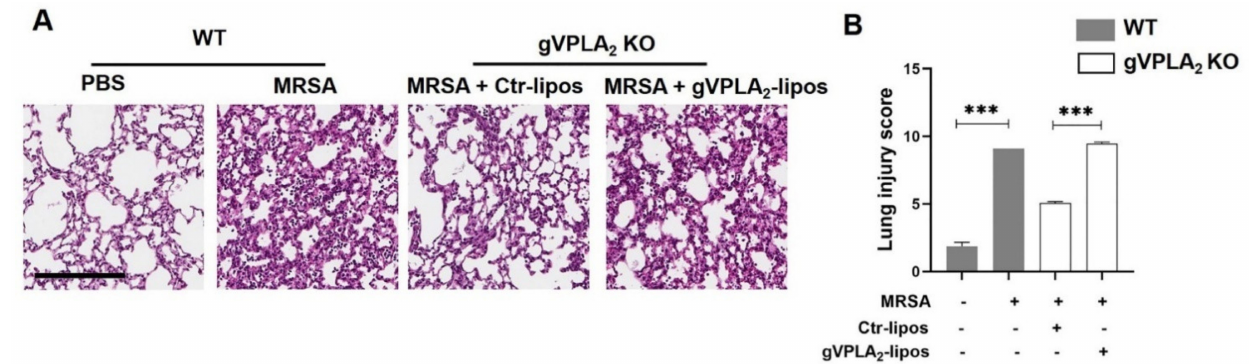
Figure 9. Effects of gVPLA 2 expression on lung tissue histopathology. H&E staining of lung sections that were obtained from WT or gVPLA 2 KO mice treated with live MRSA-USA300 (0.75 × 10 8 CFU/mouse) intratracheally for 18 h. gVPLA 2 KO mice were administrated intravenously ACE-conjugated liposomes containing either gVPLA 2 plasmid (gVPLA 2 -lipos) or empty vector (Ctr-lipos). Lung tissues were scanned at 40 × and representative pictures were taken at 20 × . ( A ): Shown are representative images from each experimental group. Scale bar: 200 µ m. ( B ): Graph bars depict lung injury scores for each experimental group. *** p < 0.001. n = 3–4